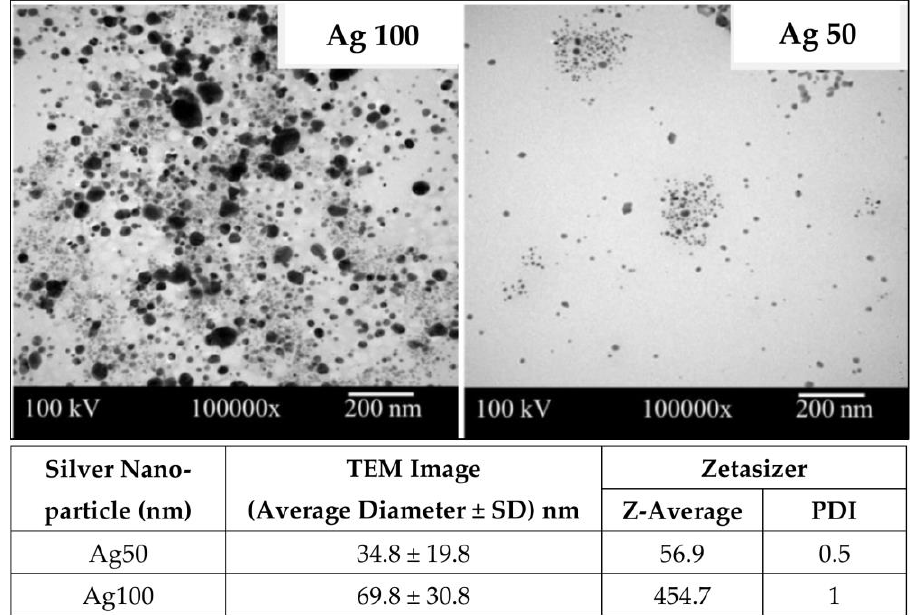
Figure 1. TEM images of silver nanoparticles (AgNPs), Ag100 and Ag50. The average diameters of AgNPs from TEM images were measured by using image J program. The average sizes of AgNPs in DI water were analyzed by using Zetasizer (Malvern Zetasizer ZSP, Worcestershire, UK).